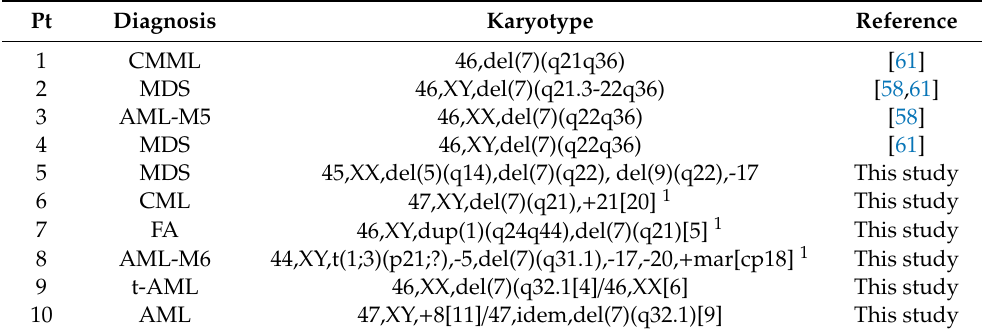
Table 1. Clinical and cytogenetic features of the patients analyzed in this